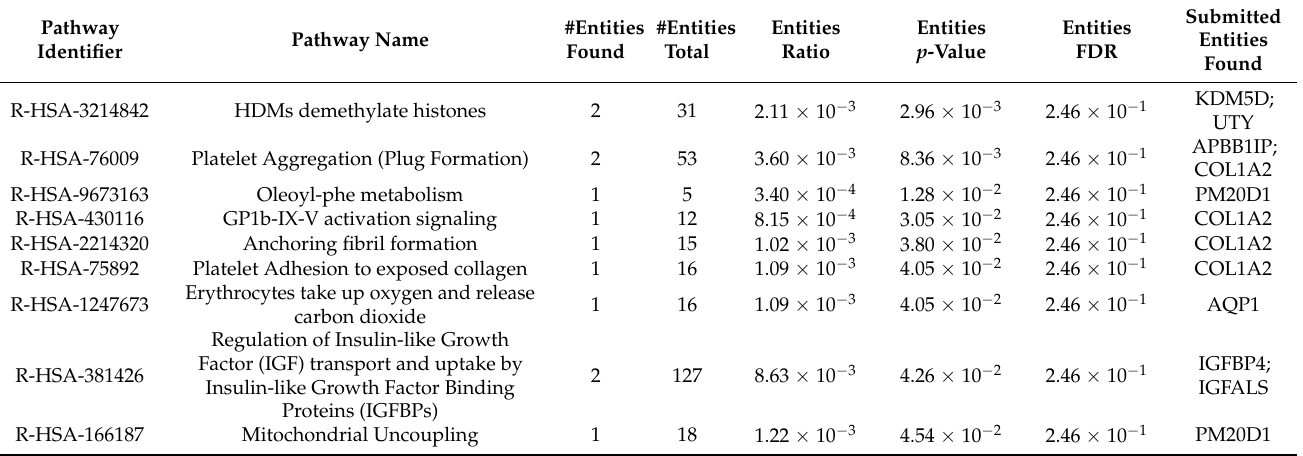
Table 1. The pathway enrichment result of the significant male-vs.-female DEGs in healthy cartilage against the Reactome knowledgebase ( p < 0.05). Note: no pathways have an FDR value less than